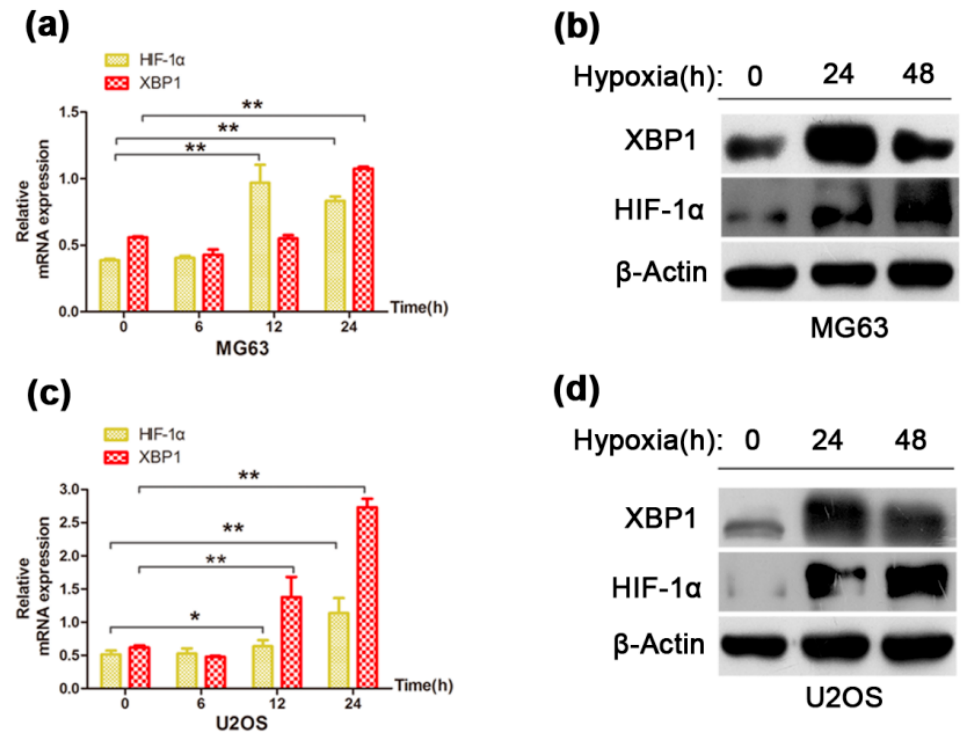
Figure 3. The up-regulation of XBP1 under hypoxia condition in OS cells. ( a , c ) The mRNA expression of XBP1 and HIF-1 α in MG63 and U2OS cells for indicated h of hypoxia (1% O 2 ) treatment; ( b , d ) The protein expression of XBP1 and HIF-1 α in MG63 and U2OS cells for indicated h of hypoxia treatment. HIF-1 α expression demonstrated specificity of treatment to hypoxia. β -Actin was used as an internal control. Error bars represent mean ± s.d. of triplicate experiments.* p < 0.05, ** p < 0.01 by Student’s t -test.